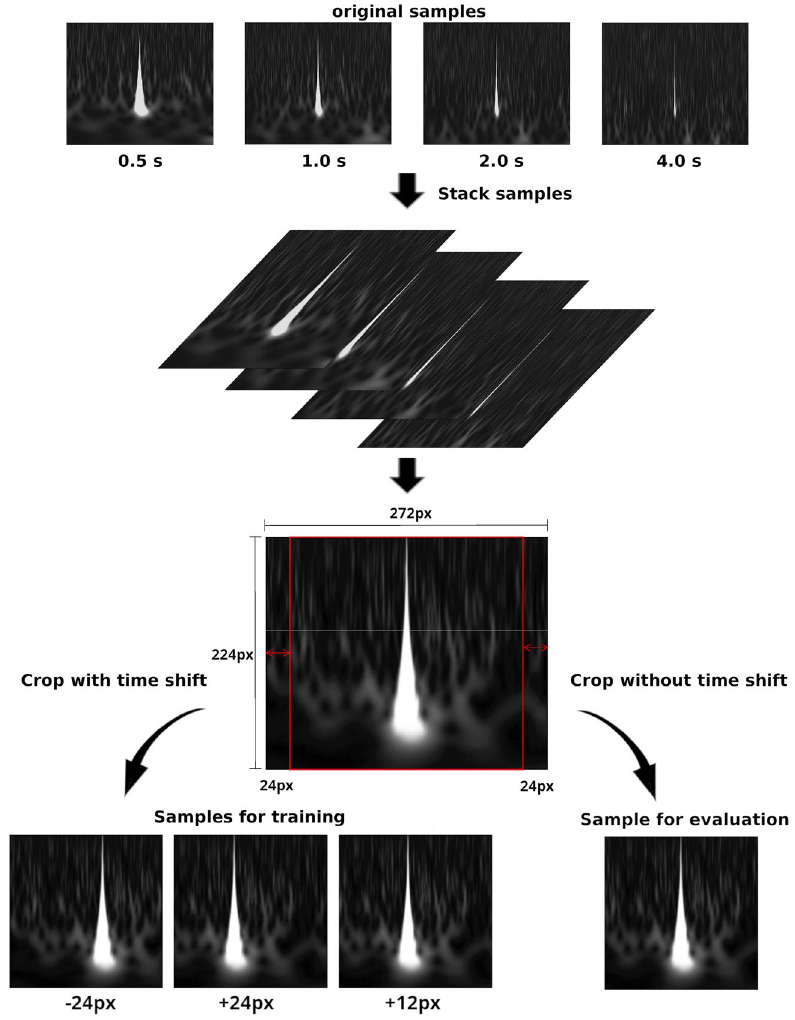
Figure 7. Overview of the input data pre-processing. The original samples are stacked in four time durations (0.5, 1.0, 2.0, and 4.0 s) to generate the data, where the width and height of each image are 224 px and 272 px, respectively, and the dimensions of the stacked data are 4, 224, and 272. Considering the training process of the proposed architecture, after a random time shift of image in the range 0–24 px, the dimensions of the data (4, 224, and 224) are cropped and the cropped data are used as training data. The data that are cropped without a time shift are used for the evaluation of the VAE and as the input image of the